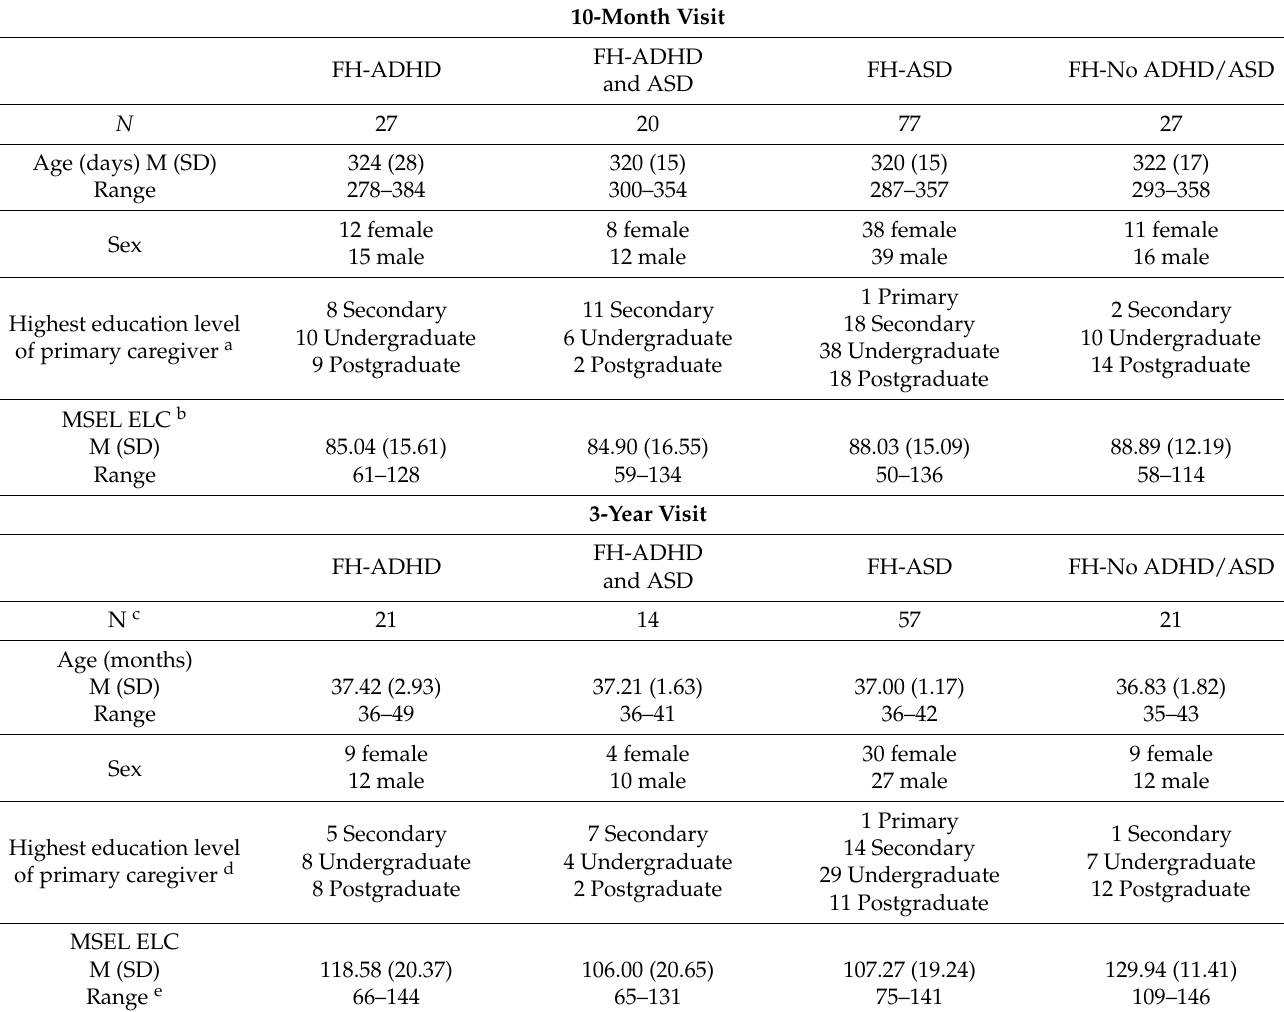
Table 1. Participant characteristics at the 10-month and 3-year laboratory